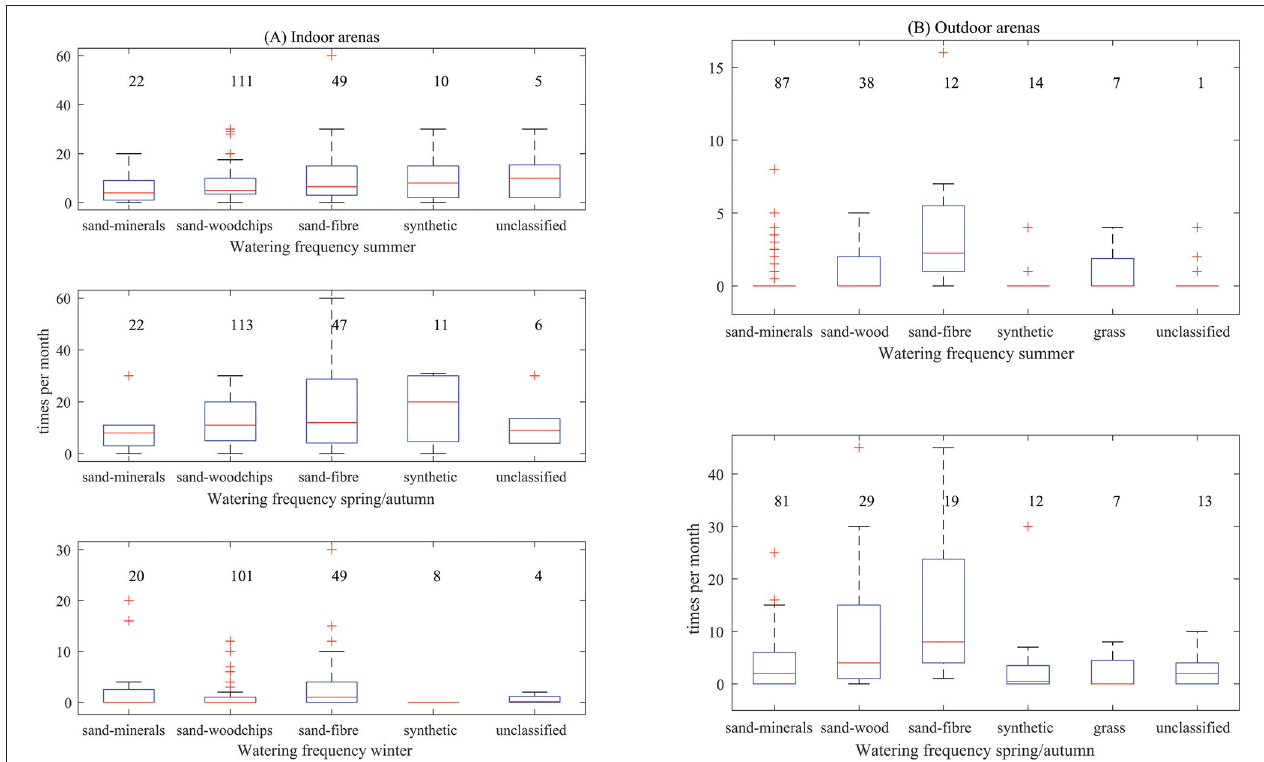
FIGURE 3 | Watering frequency by season for indoor (A) and outdoor (B) arenas by top-layer category. Data from a pool of 656 riding arenas identified in a questionnaire in Sweden 2014. N for each category is given in the